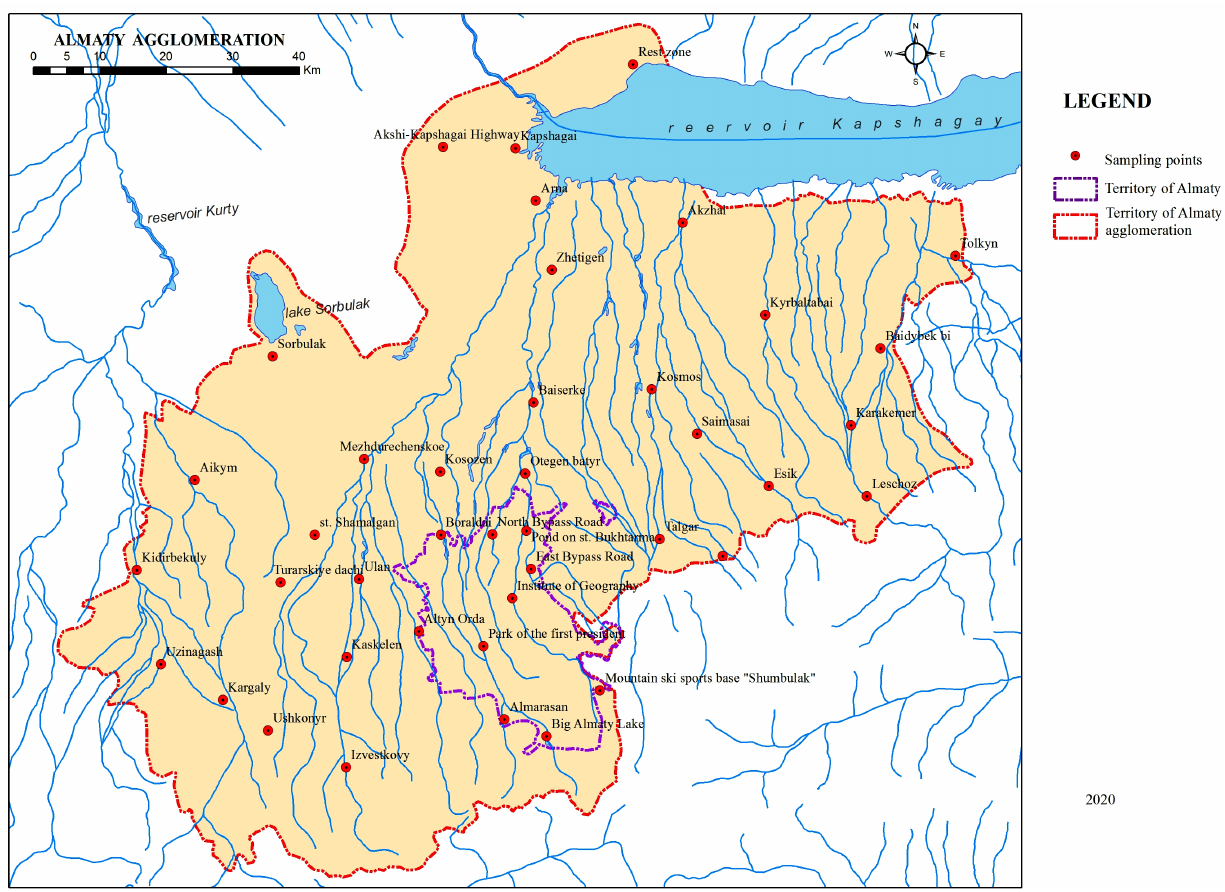
Figure 1. Location of the study areas. Figure 1. Scheme of snow sampling points in 2020 (authors Madibekov A.S., Zhadi